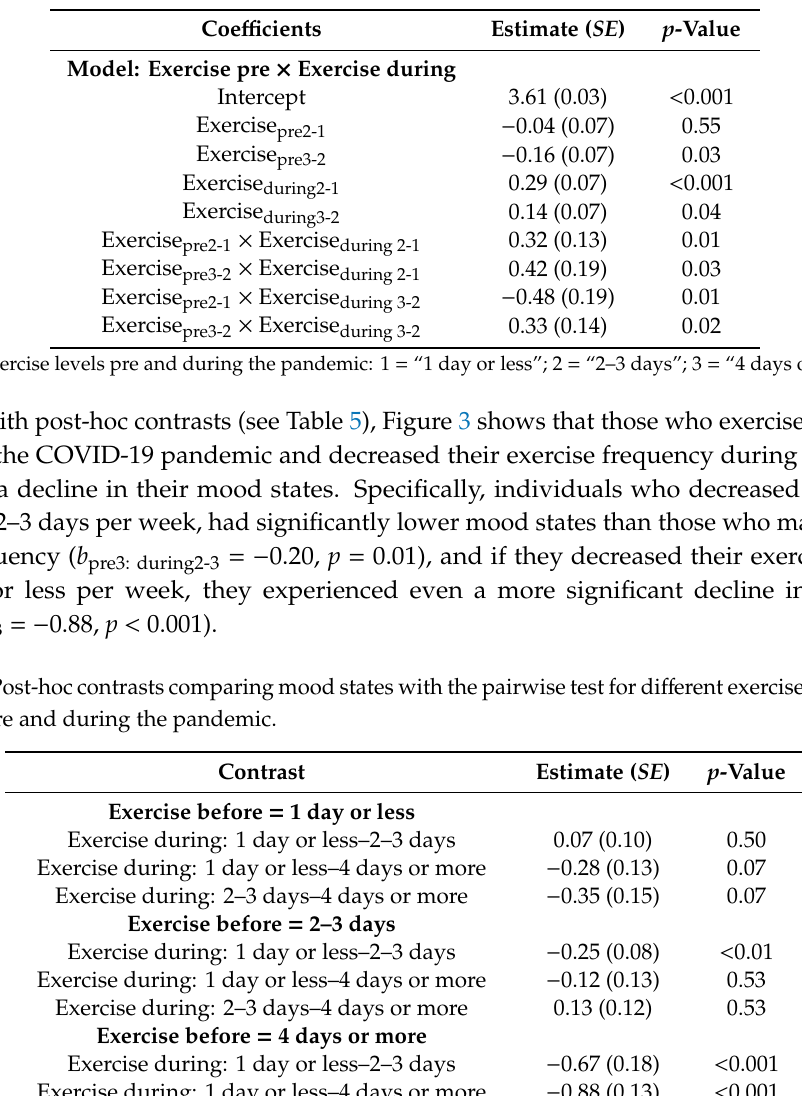
Table 4. Exercise frequency and change in mood states. Statistical results for the linear model analyzing mood states (POMS) with exercise frequency pre and during the pandemic.